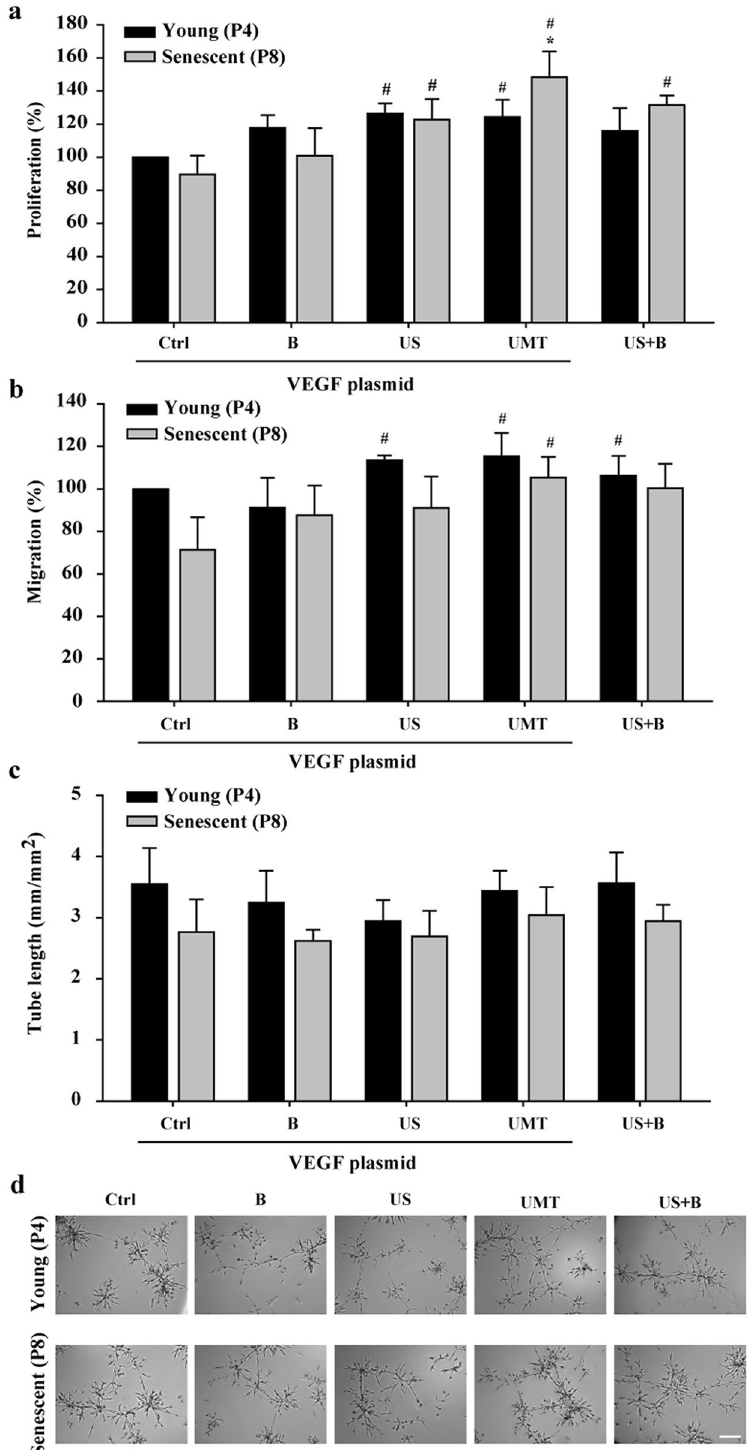
Figure 5. Effects of UMT-mediated VEGF transfection on the angiogenic activities of transfected young and senescent porcine EPCs. At 48 h after transfection, the cells were evaluated for proliferation by a BrdU incorporation assay ( a ), by a migration assay ( b ), and by a tube formation assay ( c ). Representative micrographs are shown ( d ). Scale bar: 250 µm. Migration and tube formation were analysed with Leica QWin image analysis software (Cambridge, UK, version number: V3.5.2). See the text for details. n = 6 for each bar. * P < 0.05 vs. the leftmost black bar. # P < 0.05 vs. the leftmost grey bar. All abbreviations are the same as those used in Figs. 1 and